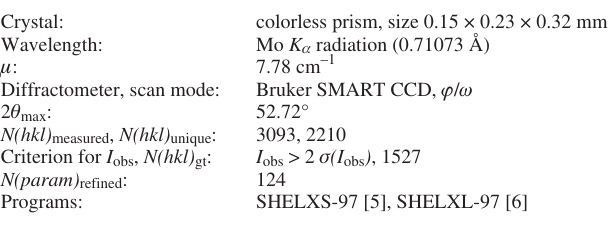
Table 1. Data collection and handling.